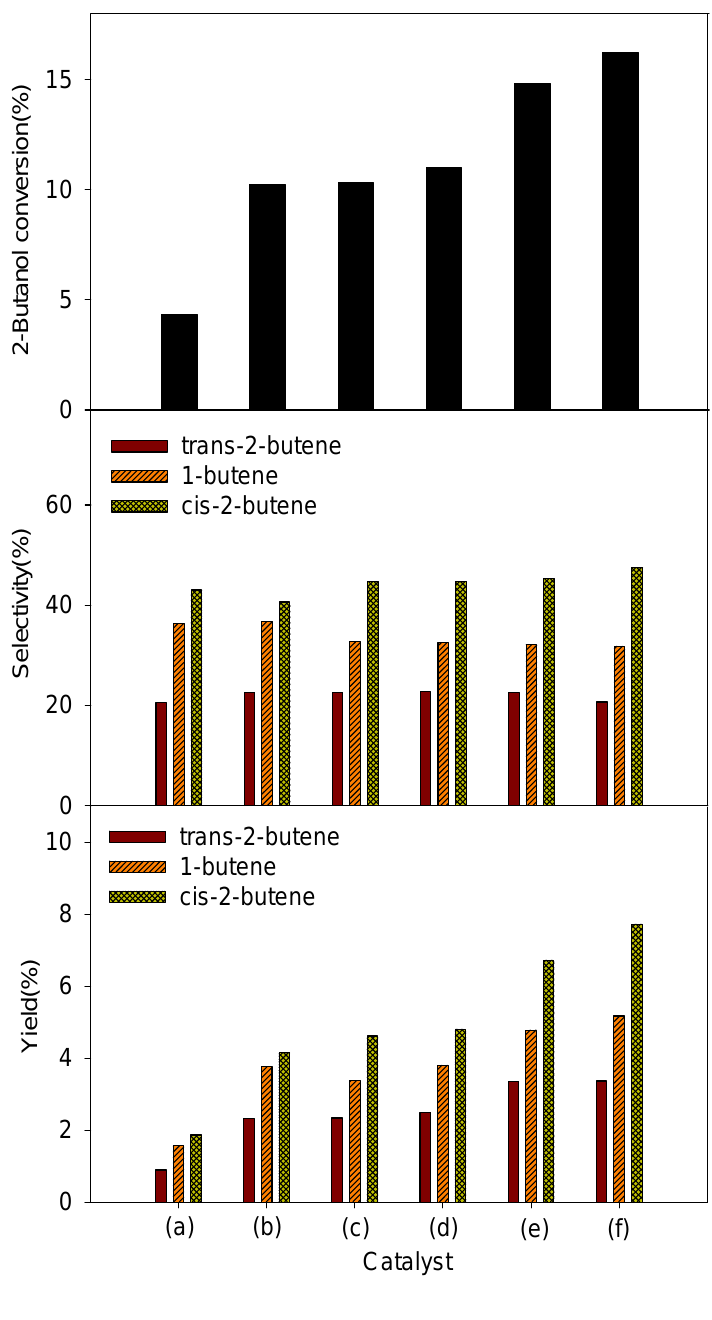
Figure 8. Conversion, selectivity, and yield of 2-butanol dehydration over various catalysts: ( a ) MCM-41; ( b ) TiO /MCM-41; ( c ) V 2 O (7.6)-TiO /MCM-4; and ( f ) V ( e ) V 2 5 2 1 atm, WHSV 80 h − 1